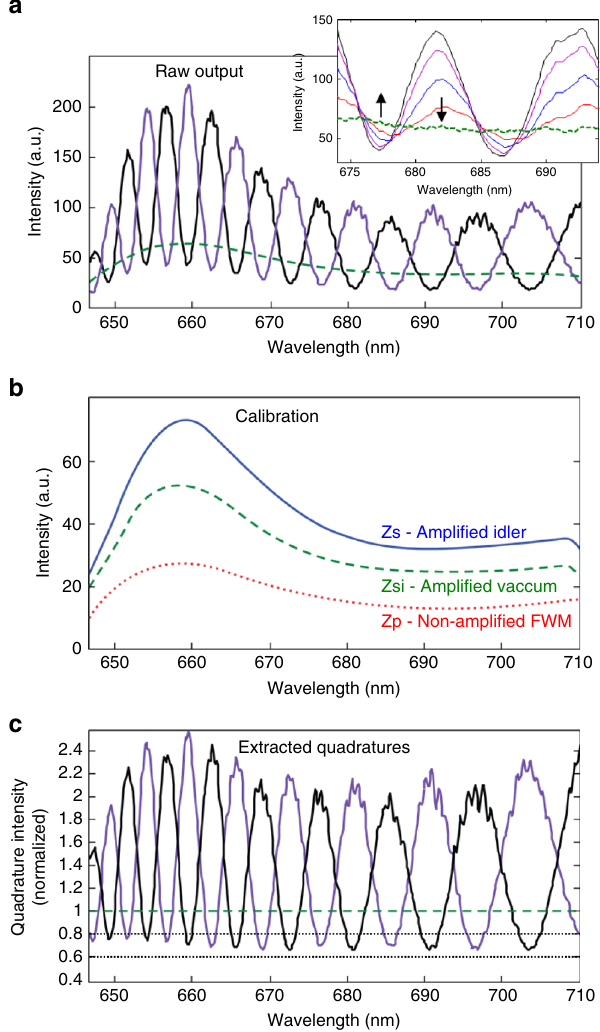
Fig. 3 The procedure of parametric homodyne. Measurement of the quadratures includes three stages: a raw output measurement, b calibration, and c quadrature extraction. a Raw output measurements: In the most general case of arbitrary parametric gain, two measurements are needed to extract the quadrature information: (1) amplifying one quadrature (black); and (2) amplifying the orthogonal quadrature (purple). The speci fi c quadrature to be ampli fi ed is de fi ned by tuning the pump phase. The reduction of the raw output beneath the vacuum input level (dashed green) directly indicates squeezing. The inset shows the effect of loss at the input FWM light on the parametrically ampli fi ed output. As the loss is increased, the squeezing is reduced and the observed fringe minima rise towards the vacuum level (vertical arrows) even though the total input intensity is considerably decreased (a non-classical signature). b Calibration: To calibrate the parametric ampli fi er, the output response is measured for a set of three known inputs: (1) idler-input only (blocked signal, I zs — solid blue), (2) vacuum input (blocked entire FWM — both signal and idler, I zsi — dashed green), and (3) zero ampli fi cation (blocked pump, I — dotted red). c Extracted quadratures (black and purple in accordance zp with a ) — with the analysis detailed in the Methods, quadrature information is extracted. Quadrature squeezing is evident across the entire 55 THz (cid:1) (cid:3) (cid:4) 0 : 68, 32% below the vacuum level spectrum down to x y x